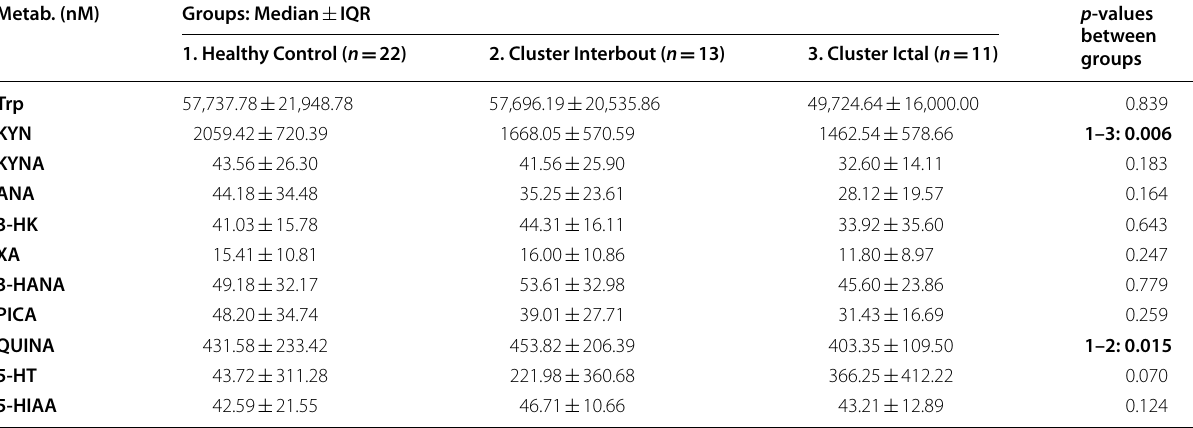
All p-values were added in the table between control and headache periods of cluster patients. Significant differences were revealed between control and ictal data in case of KYN and between control and interbout data in case of QUINA IQR interquartile range, Metab metabolites, Trp Tryptophan, KYN L-kynurenine, KYNA Kynurenic acid, ANA Anthranilic acid, 3-HK 3-hydroxikynurenine, XA Xanthurenic acid, 3-HANA 3-hydroxianthranilic acid, PICA Picolinic acid, QUINA Quinolinic acid, 5-HT 5-hydroxytryptamine, 5-HIAA